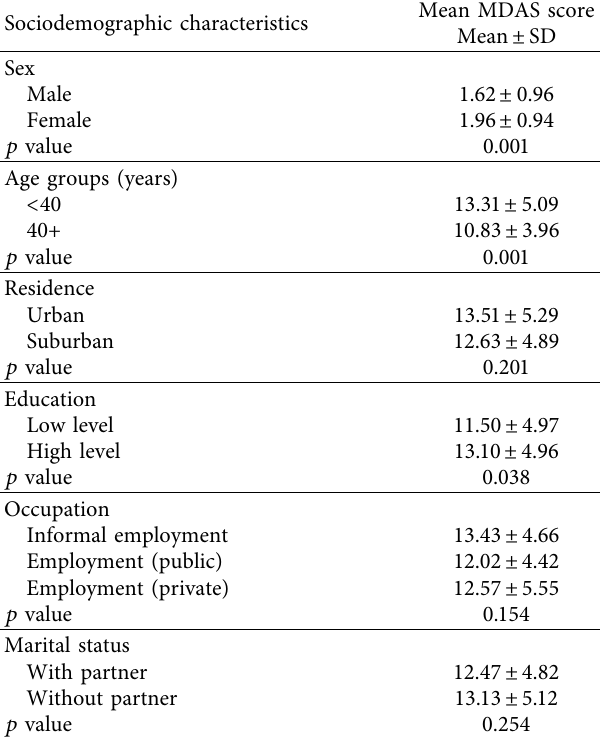
Table 3: Overall mean MDAS score according to social-demo- graphic characteristics of the